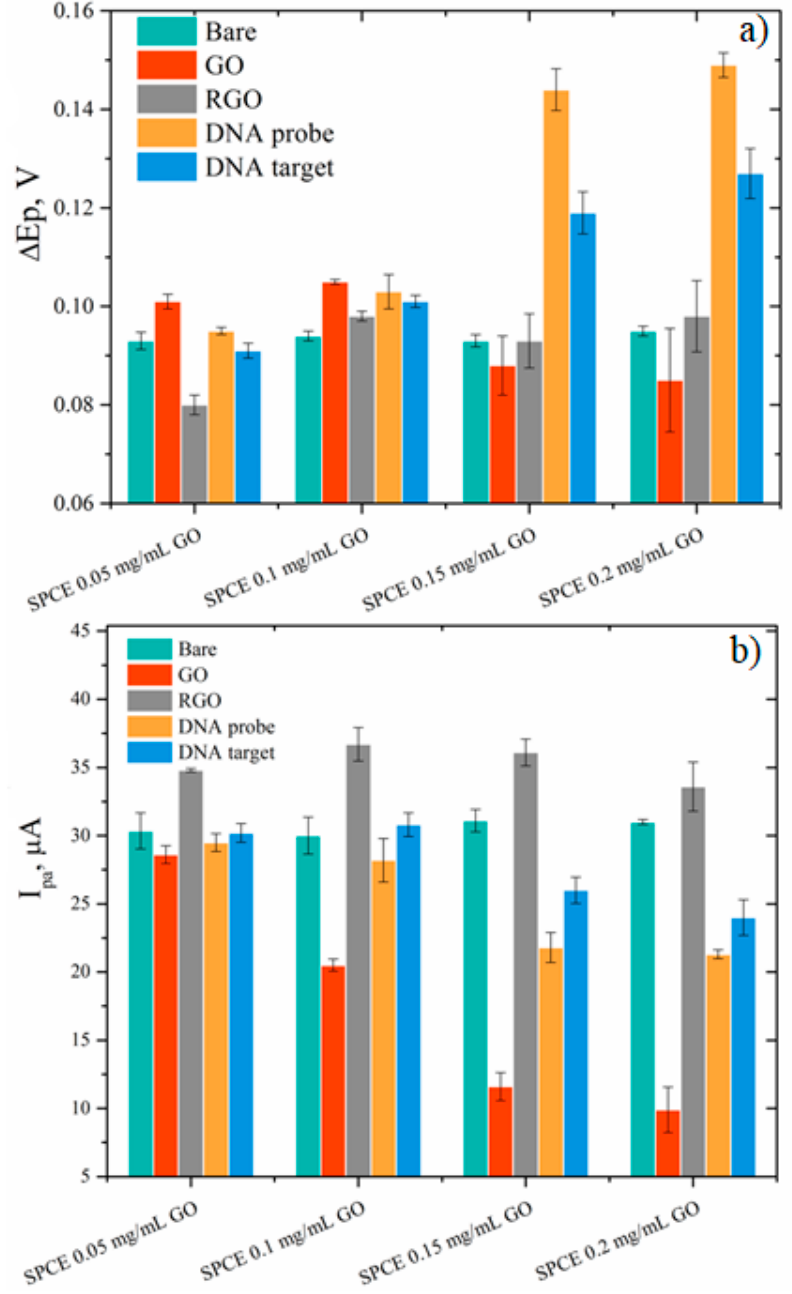
Figure 11. ( a ) Peak separation values ( Δ E p ) ( b ) and anodic peak currents (I pa ) resulting from CV measurements recorded in 1 mM [Fe(CN) 6 ] 3 − / 4 − , 0.1 M KCl, after every modification stage of SPCEs electrodes: drop-casting of GO dispersions of different concentrations (GO), electrochemical reduction of GO (RGO), adsorption of ssDNA probe (10 µM) on RGO-SPCEs (DNA probe) and hybridization with 100 nM target DNA (DNA target). Error bars represent standard deviation with n = 3.